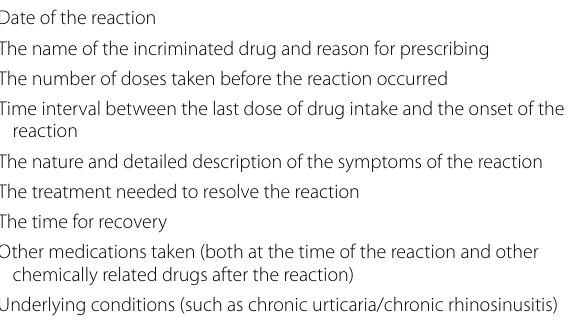
Table 3 Data that should be recorded by the primary care physicians in the clinical history of patients with sus- pected drug